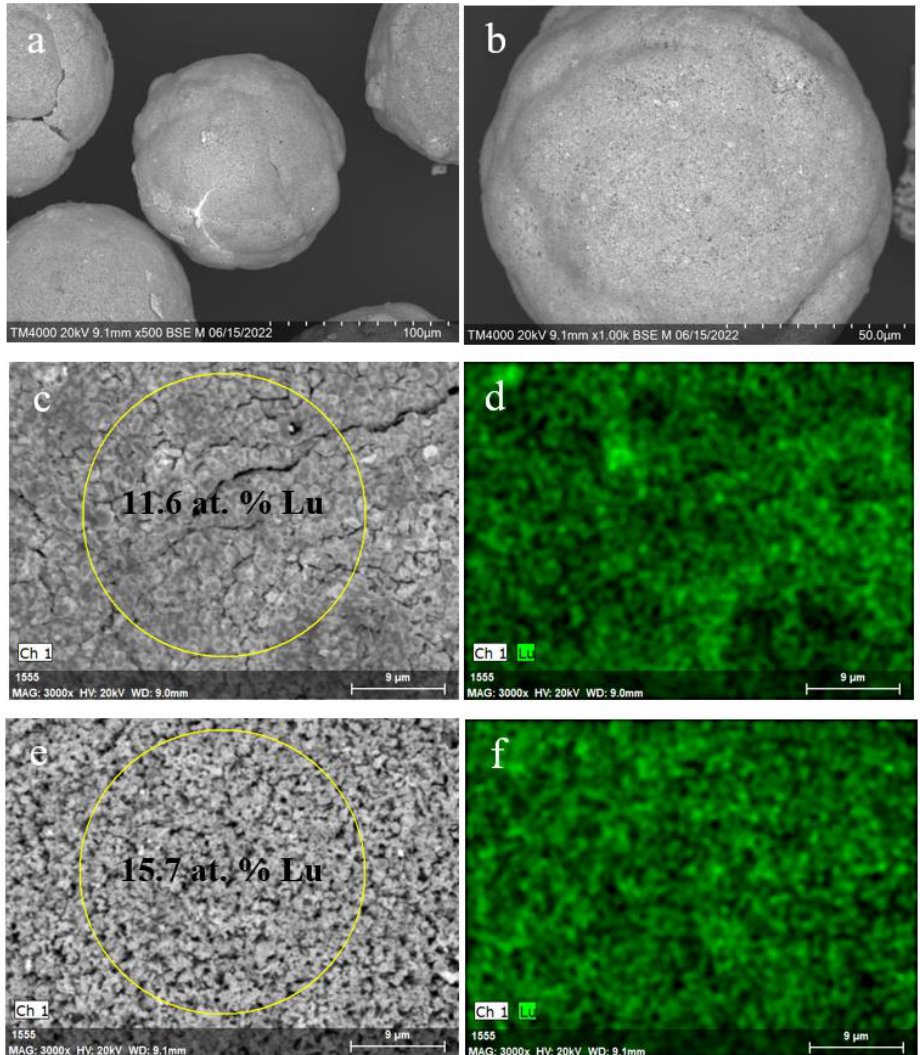
Figure 8. SEM images of the Lu 3+ loaded NaP1 microspheres ( a , b ) and local parts of the microsphere external surface ( c , e ) after thermal treatment at 1273 K; Lu distribution maps ( d , f ) for the local parts ( c , e ) of the microspheres.